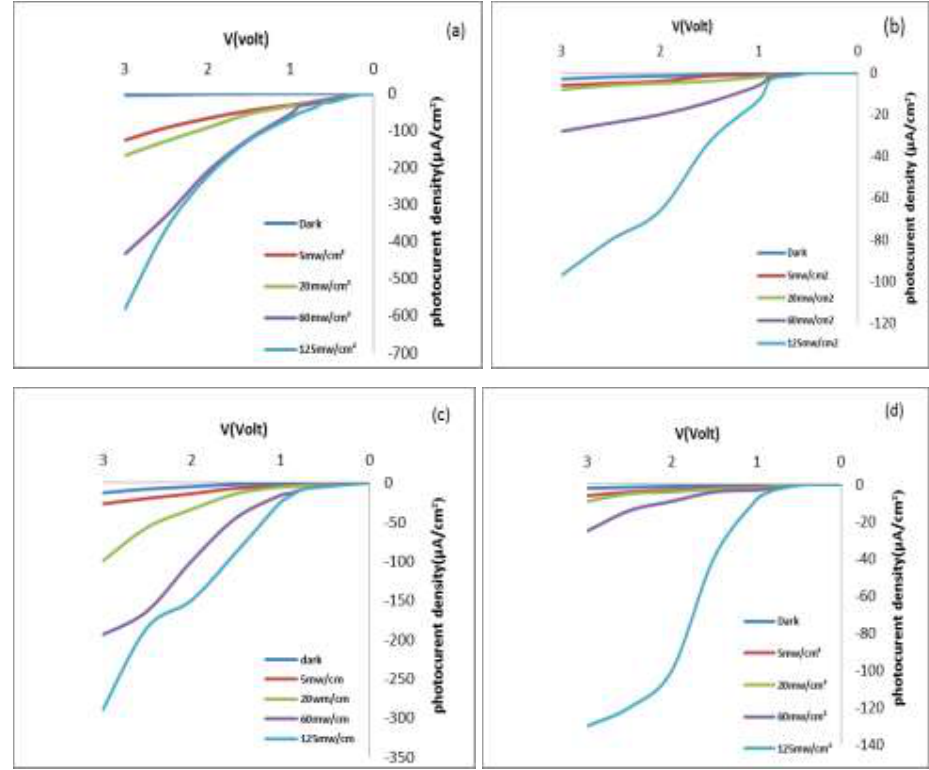
Figure 5: J ph -V characteristics for (a) C-Si and PS samples with etching times of (b) 5 minutes, (c) 15 minutes, and (d) 25 minutes, etching current density of 20 mA/cm 2 , at HF concentration 20%. The spectral response of Al/PS/Si/Al in the wavelength range 400–900 nm at 2 biased eV as shown in figure 6 in the photodetector system. The response is a function used to determine the value of the detection signal in the Al/PS/n-Si/Al answer; there are two peaks, the first peak states that the 600nm wavelength is absorbed in the PS contact depletion region, the second response peak is the result of 800nm absorption in the region C-Si contact depletion The PS response is improved with increased etching time. So, when pore size of PS is changed, the responsivity of PS changes as well. whereas porous silicon is a new material of great scientific and applied interest, due to its strong quantum confinement properties